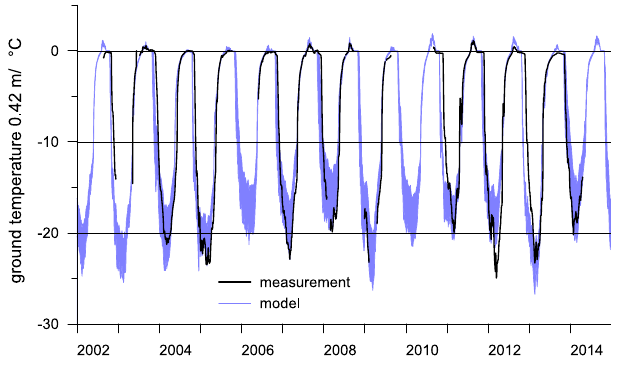
Figure 4. Modeled and measured ground temperatures at a depth of 0.4m at a wet polygon center on Samoylov Island (Boike et al., 2013). The blue area depicts the spread between model runs with snow densities of 200 and 250kgm − 3